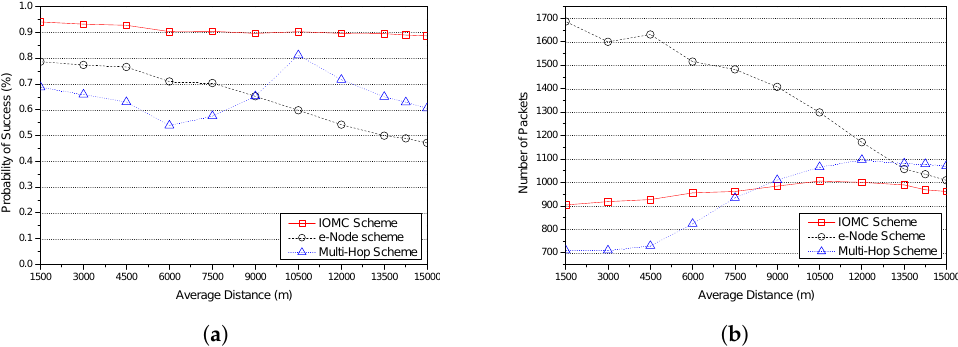
Figure 6. Plot variations in average distance with probability of success and number of packets for various schemes. ( a ) Probability of success vs. average distance. ( b ) Number of packets vs. average